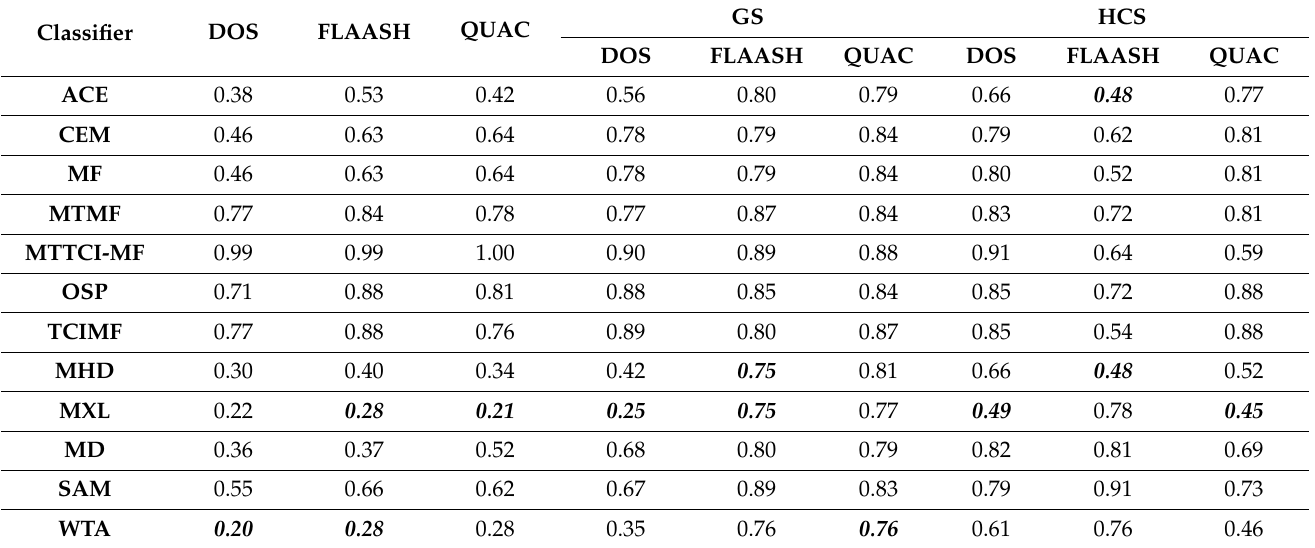
Table 10. Average performance of each classifier w.r.t. pansharpening using error rate as the comparative measure. Values of the best-performing classifiers are emboldened and